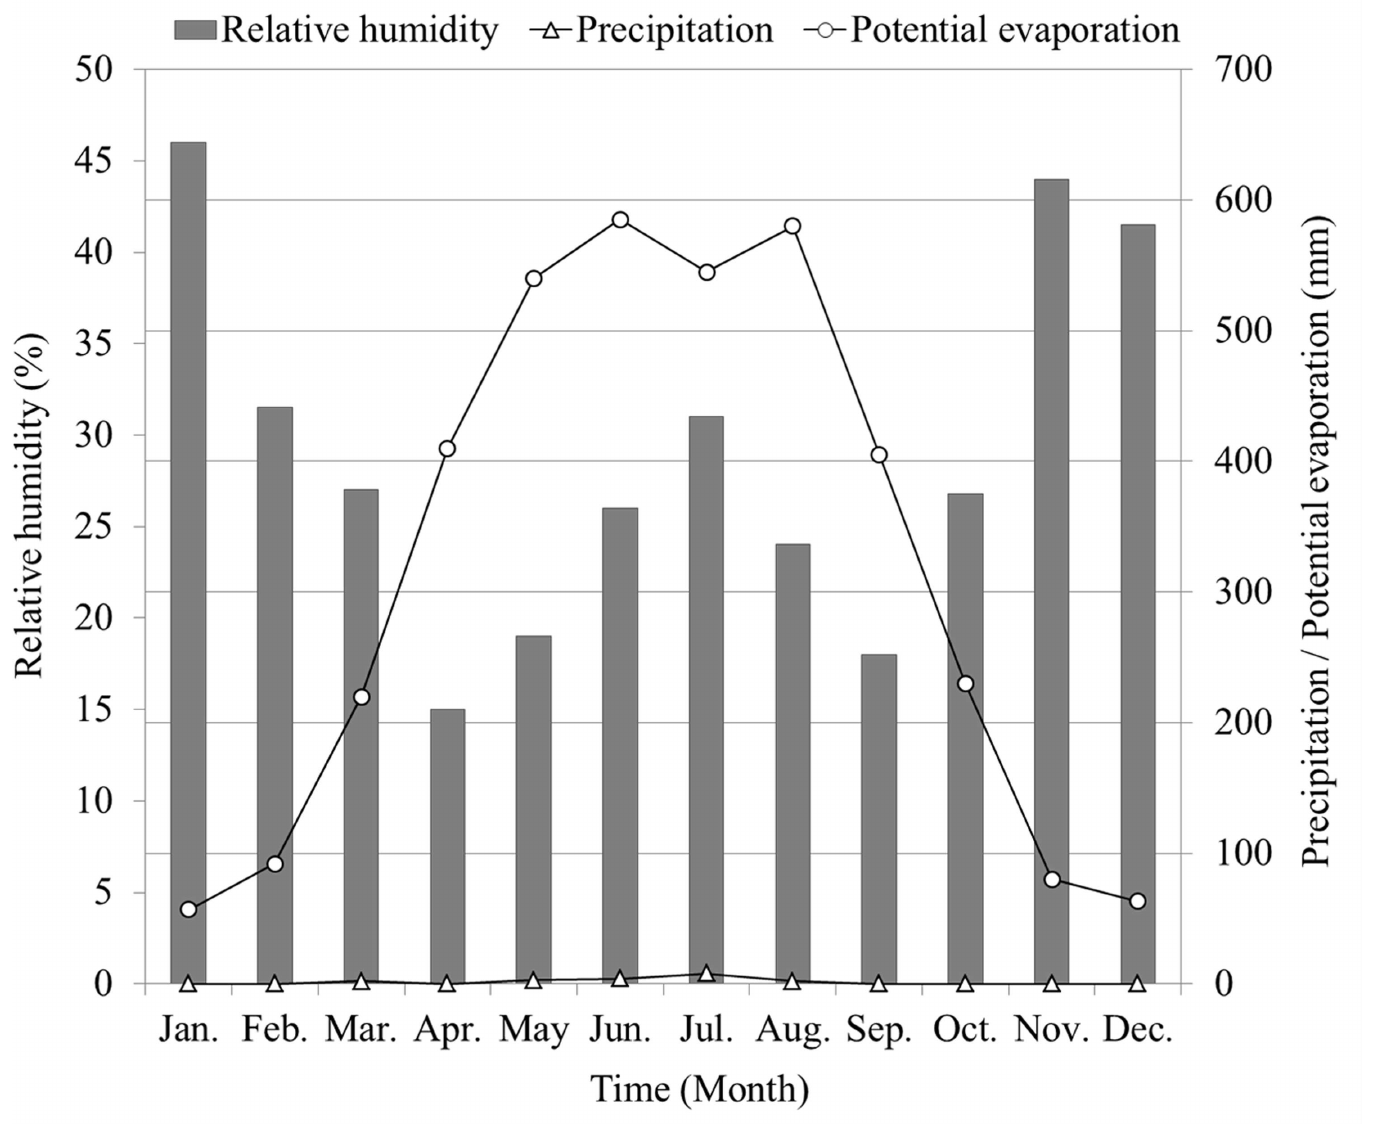
Fig 3. Relative humidity, precipitation, and potential evaporation in the hinterland of the Taklimakan